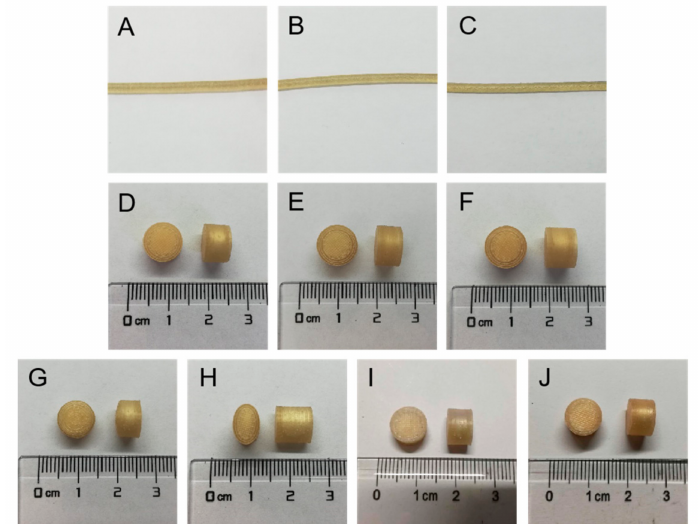
Figure 4. Photographs of the filaments and tablets: ( A ) F90, ( B ) F95, ( C ) F98, ( D ) FH-90-266, ( E ) FH-95-266, ( F ) FH-98-266, ( G ) CH-95-266, ( H ) FU-95-266, ( I ) FH-95-366, ( J )